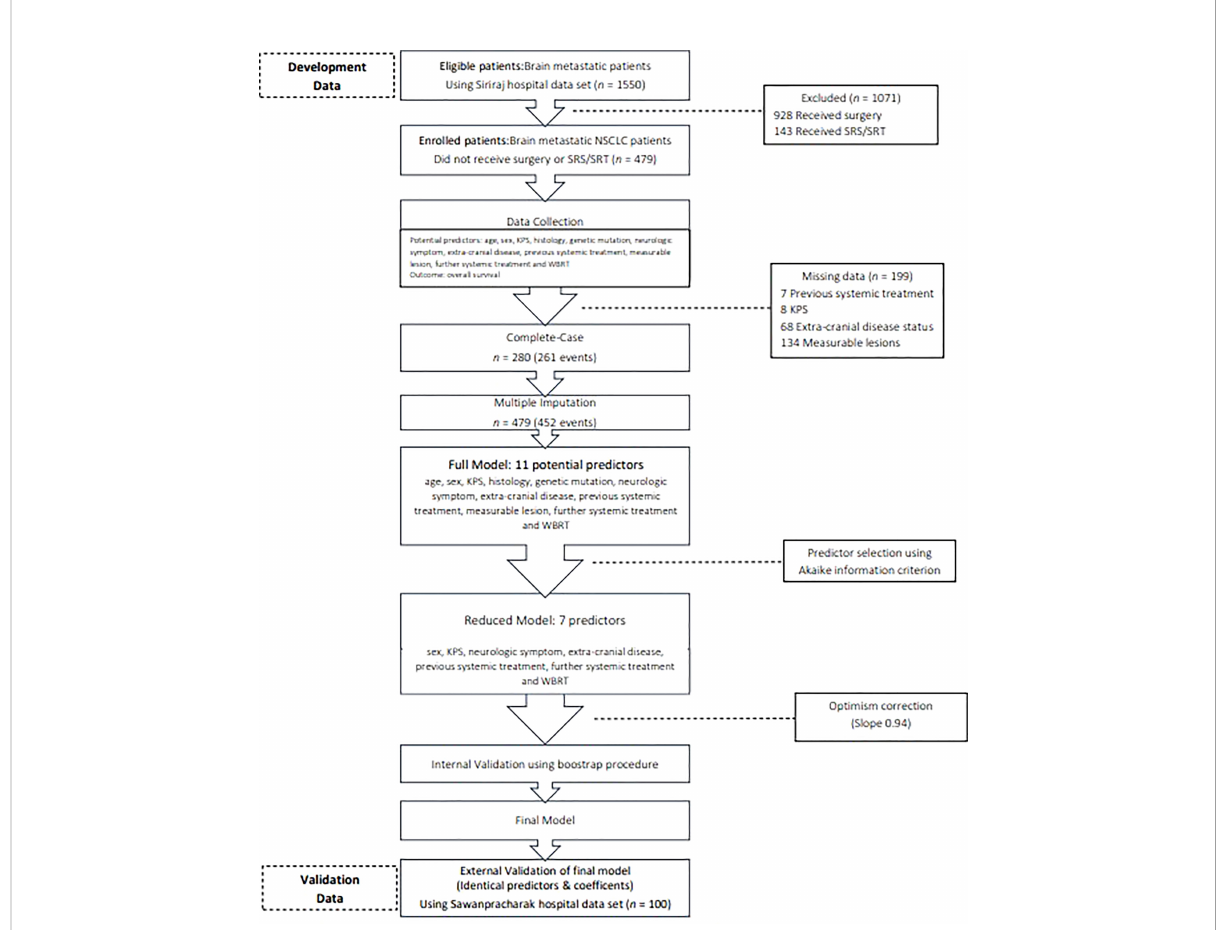
FIGURE 1 Flow diagram. KPS, Karnofsky performance status; NSCLC. non-small cell lung cancer; SRS, stereotactic radiosurgery; SRT, stereotactic radiotherapy; WBRT, whole brain